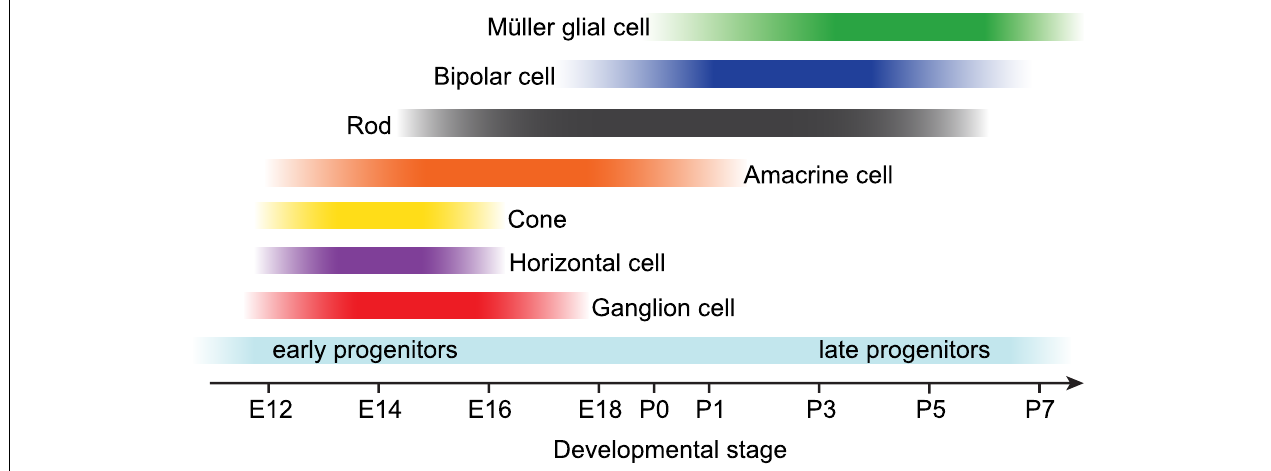
FIGURE 1 | Developmental timeline of retinal neuroepithelium-derived cell birth in rodents. Near the end of embryonic development (starting around E12 in rodents), multipotent progenitor cells become competent to produce all retinal neurons and Müller glia in a conserved, overlapping temporal sequence. Early retinal progenitors first produce ganglion cells, horizontal cells, cone photoreceptors, and most amacrine cells prior to birth. Postnatally, late retinal progenitors produce most rod photoreceptors, bipolar cells, and lastly Müller glia. Adapted from Bassett and Wallace (2012).